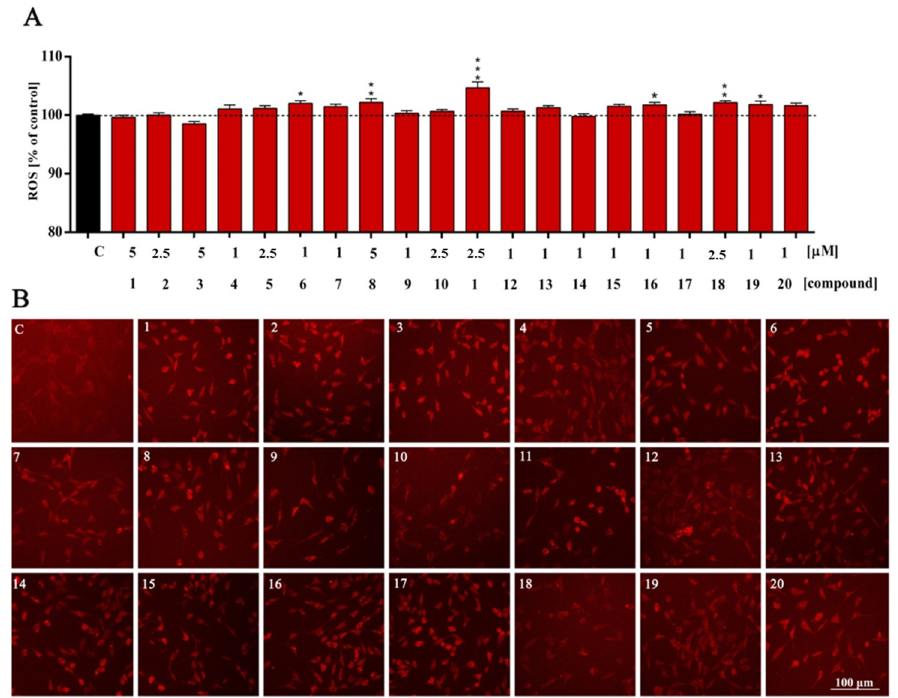
Figure 5. Reactive oxygen species (ROS) level of HT-22 cells treated with compounds 1–20 ( A ) for 48 h and representative images ( B ). All experimental groups were compared using one-way ANOVA of variance with Dunnett’s post hoc test; mean ± SD, n = 9. Statistically significant results are displayed as: * p < 0.05; ** p < 0.01; *** p < 0.001. Red fluorescence—Texas Red. Magnification of the objective lens 10×.